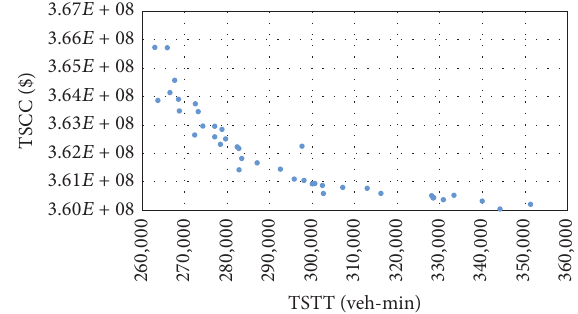
Figure 4: Multiple solutions from solving for two objectives (total system crash cost versus total system travel